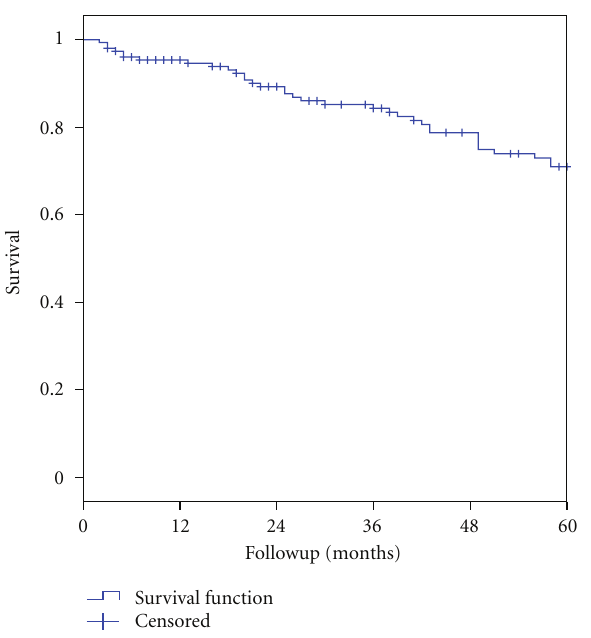
Figure 4: 5-year survival rate for all patients with small intestinal NET seen in the period from January 1994 to December 2011.